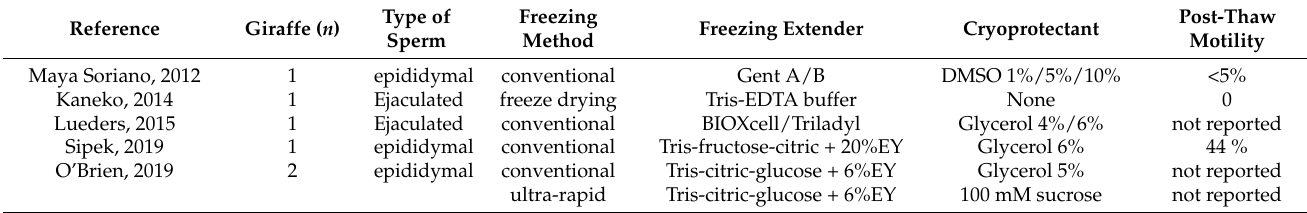
Table 1. Overview of giraffe sperm cryopreservation studies and post-thaw